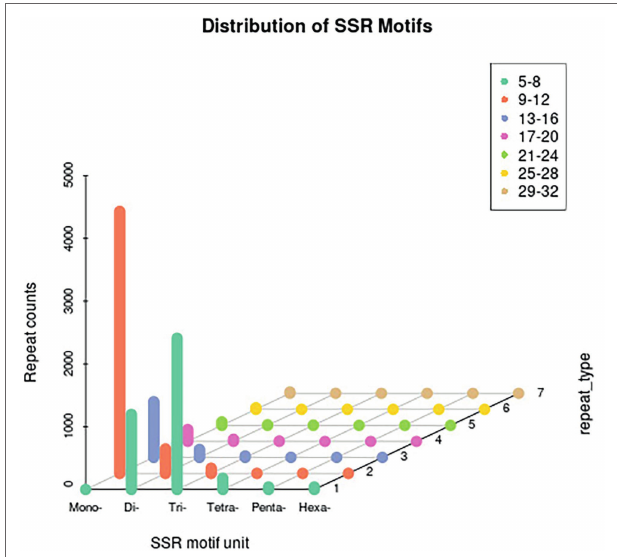
FIGURE 1 | Distribution of SSR motifs in